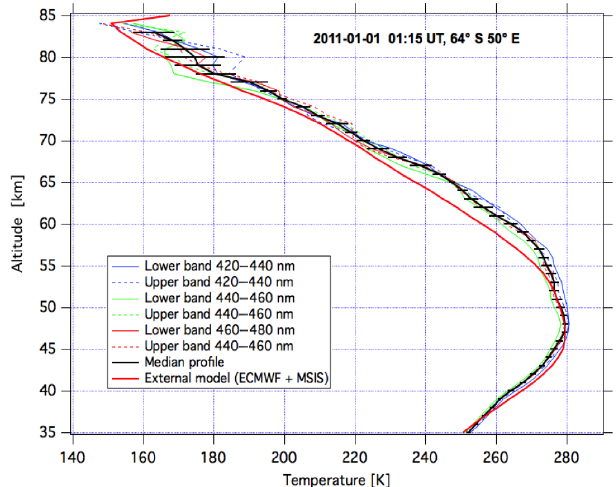
Figure 3. An example of a comparison between a Rayleigh lidar profile at OHP on 21 October 2003 (in red) and two collocated GO- MOS profiles selected using the co-location criteria (in blue and green). When two or more GOMOS profiles are selected, the me- dian profile is used for the statistical comparison. The lidar profile is plotted in red, each individual GOMOS profile is in blue and the median GOMOS profile is in green. The standard deviation of its uncertainty is represented by the shaded